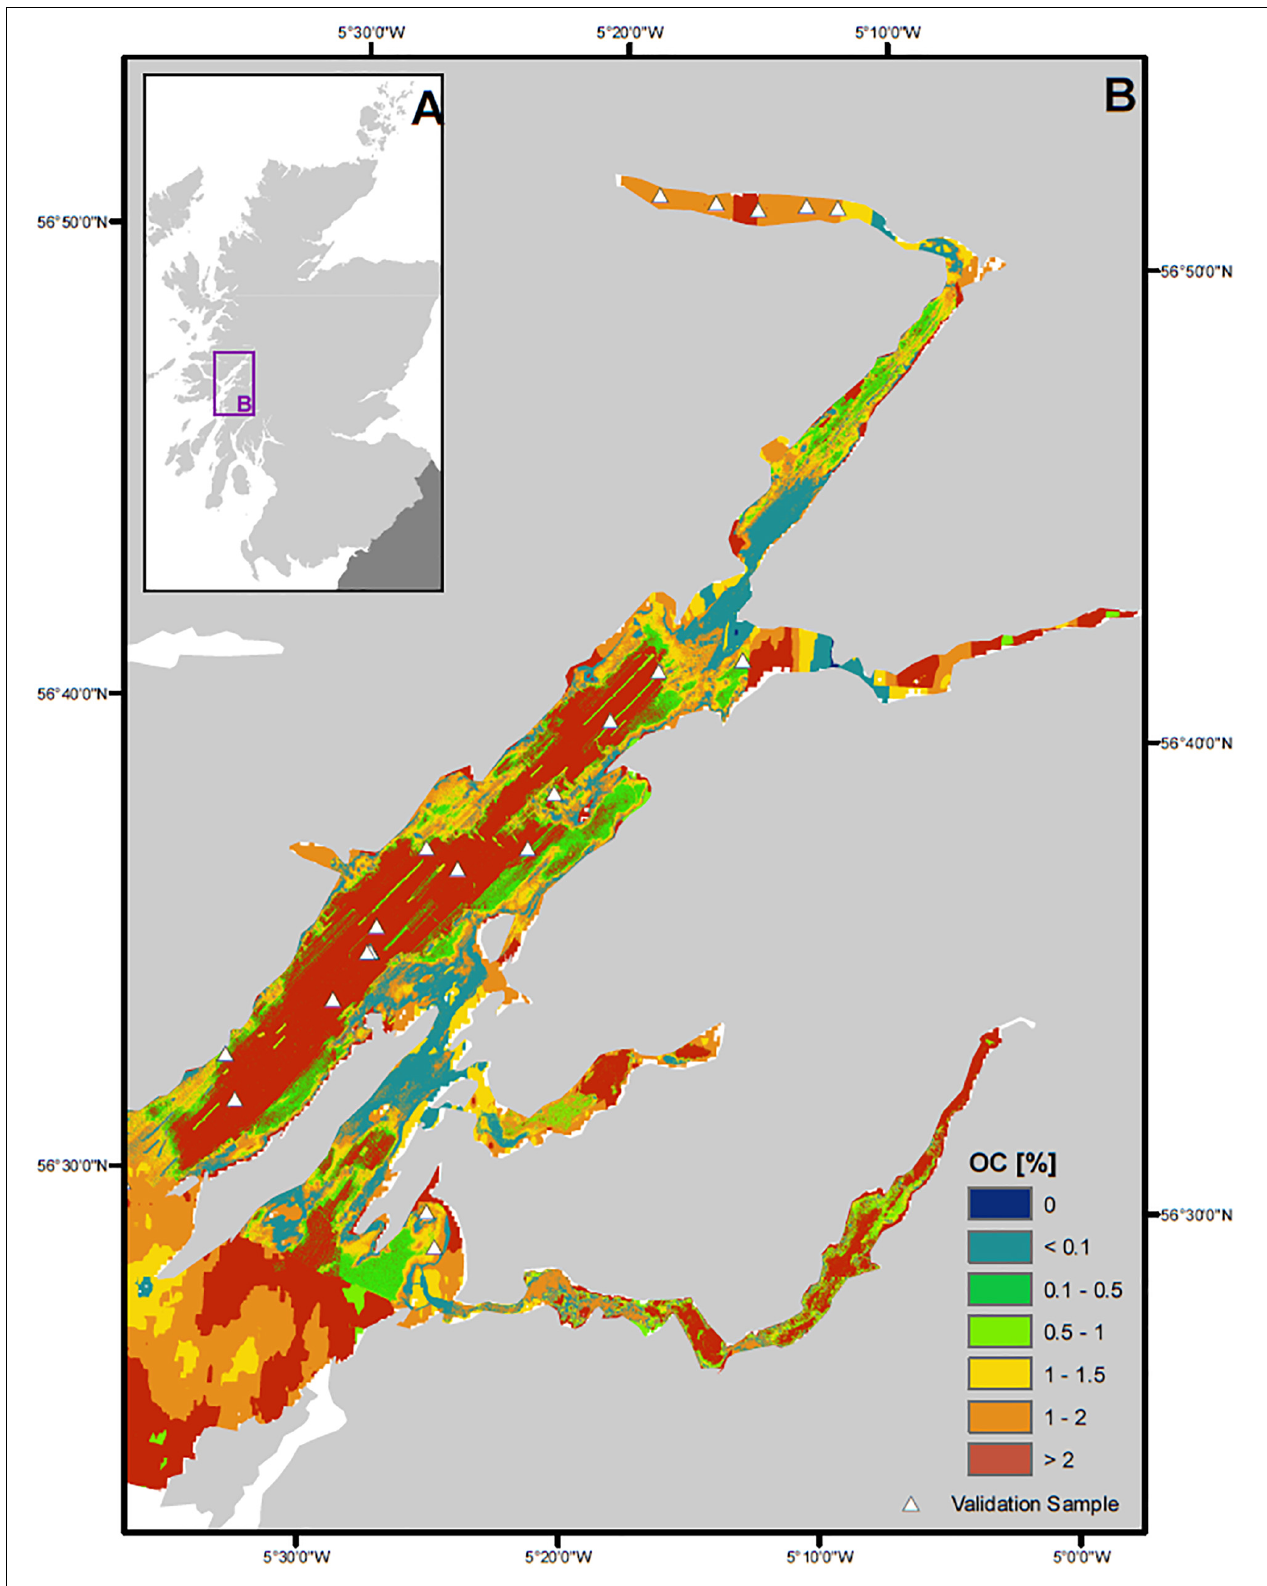
FIGURE 8 | Spatial distribution of OC in surficial sediments (top 10cm). (A) The Loch Linnhe fjord complex in context of the United Kingdom and (B) surficial sediment OC content (%).